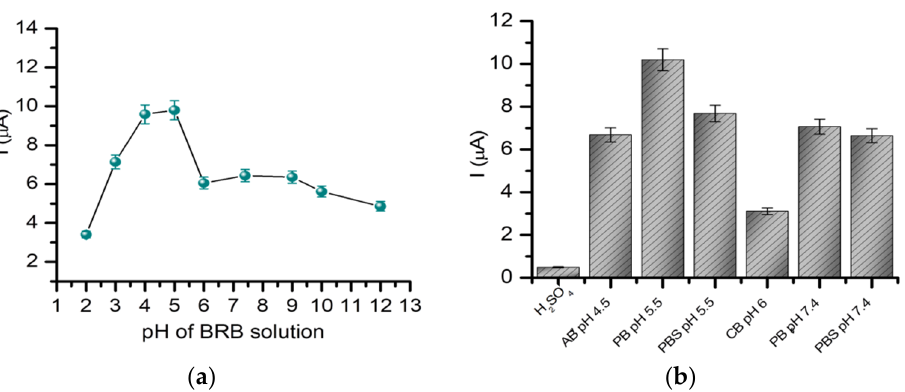
Figure 1. ( a ) Variation of the intensity of the oxidation signal of GMB in BRB solutions of different pH (2–12) on BDDE using DPV (scan rate: 100 mV/s, potential range: 0.5–2.5 V). ( b ) Variations of the intensity of the oxidation current with the electrolyte solution.